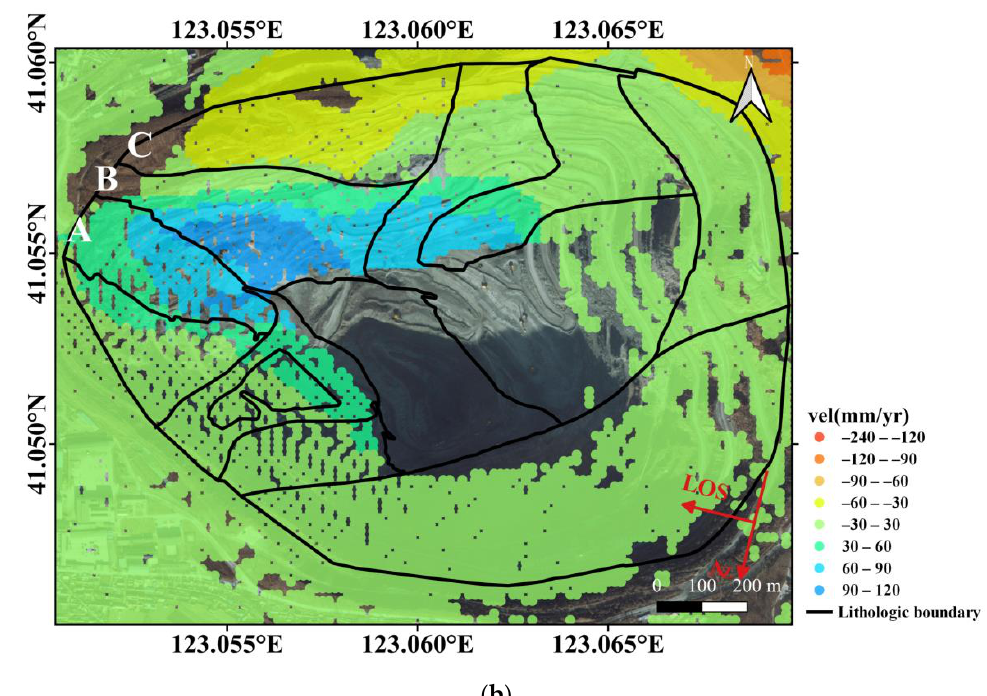
Figure 8. The LOS displacement velocities estimated from ascending ( a ) and descending ( b ) orbits, with google earth image as background. The red arrows refer to azimuth and LOS directions of the SAR sensor. Moreover, the black lines indicate lithological boundaries in the study area.